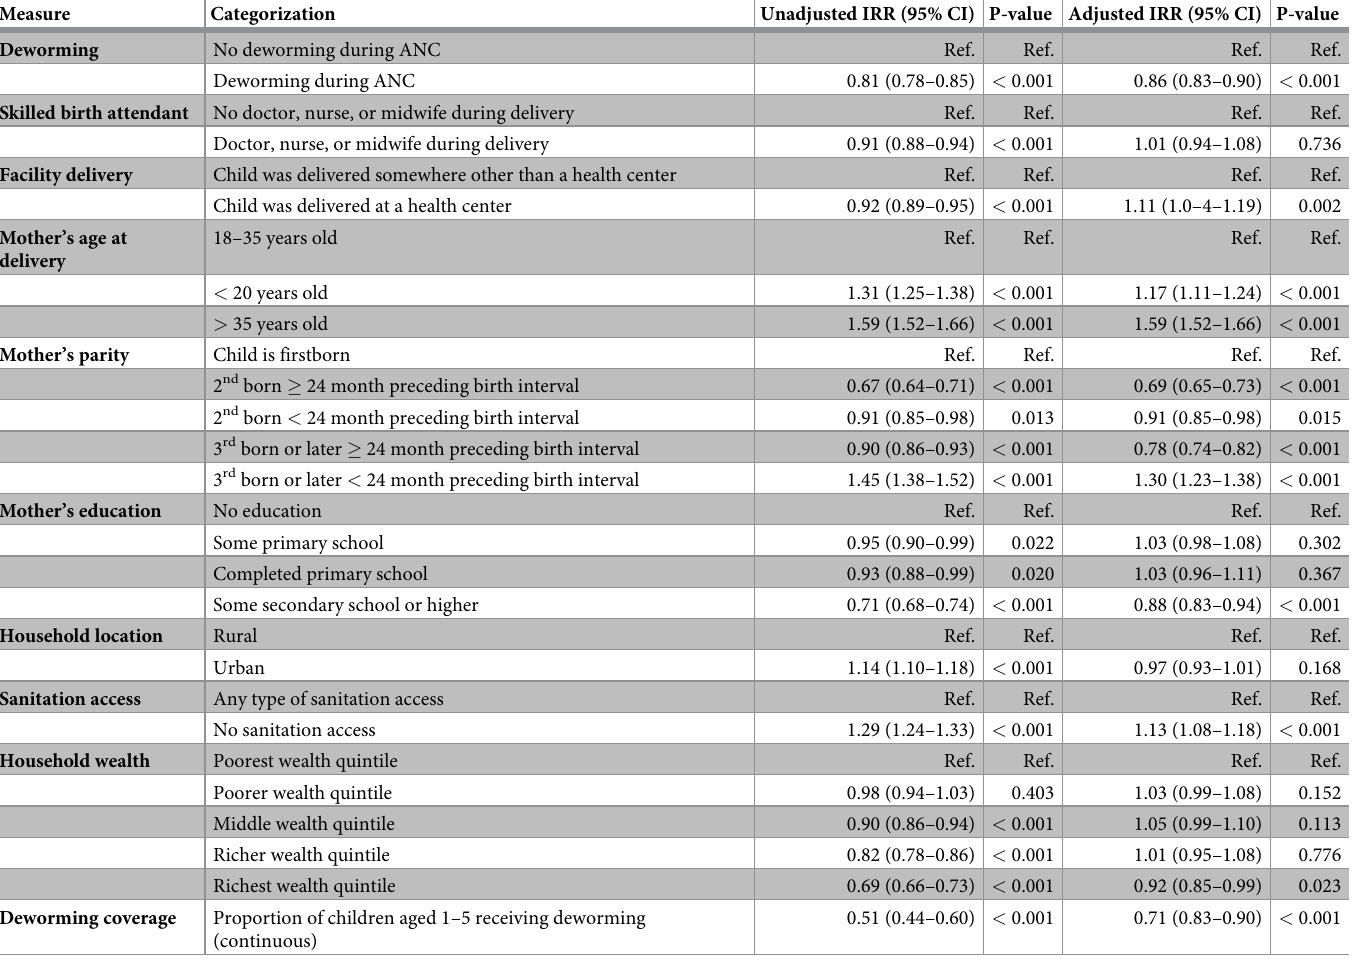
Table 2. Results from Poisson regression analysis of deworming during ANC and neonatal